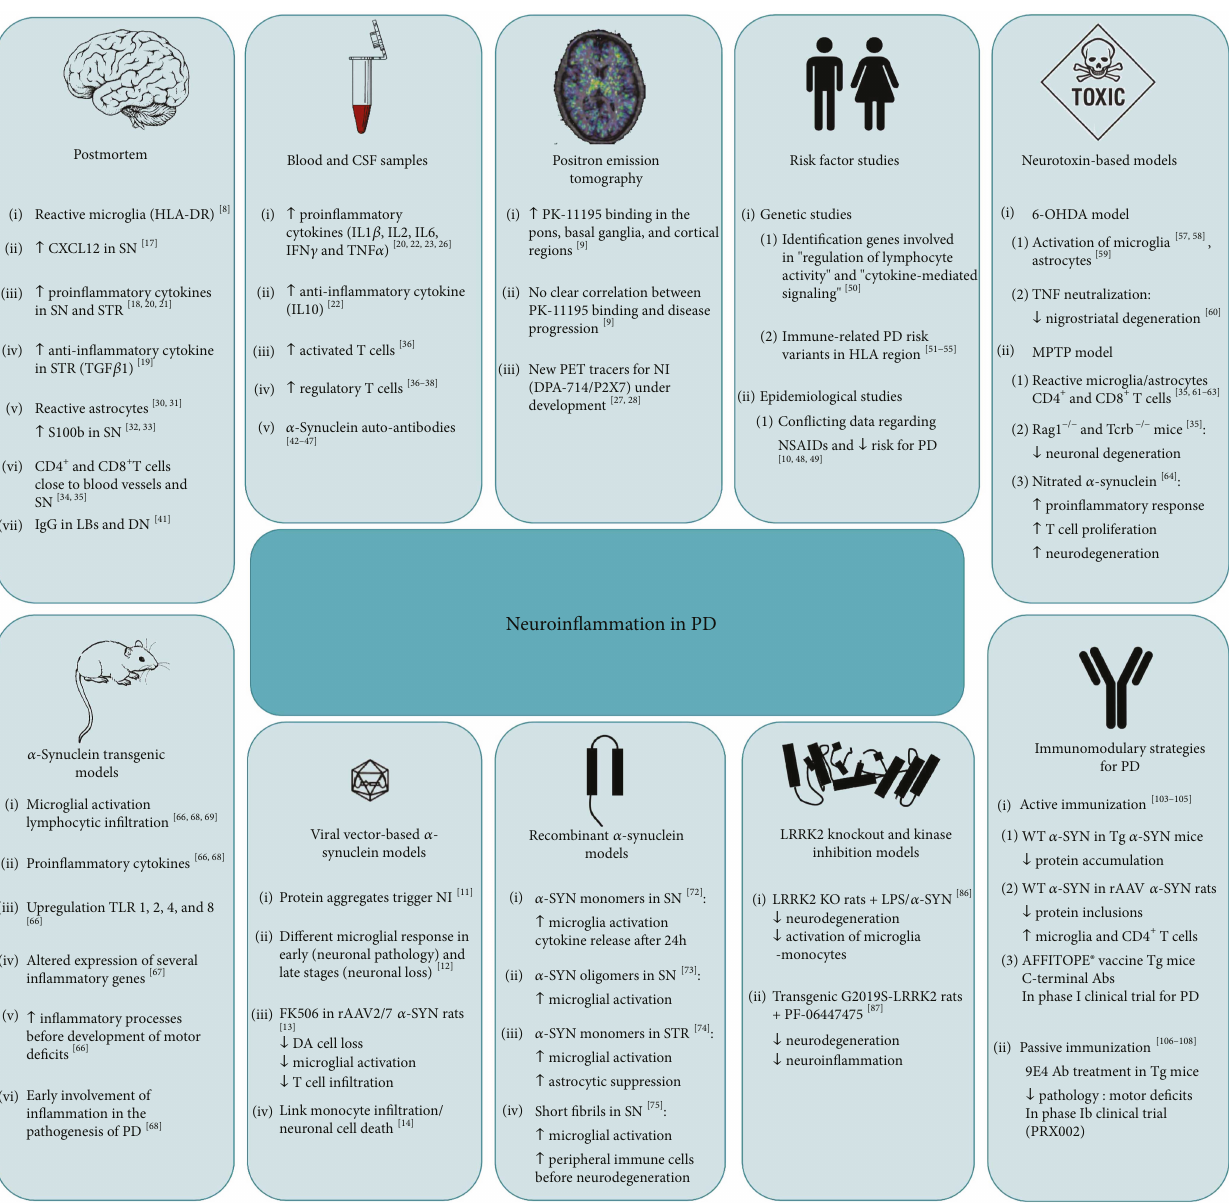
Figure 1: Overview of clinical and preclinical evidence linking neuroin fl ammation to neurodegeneration in Parkinson ’ s disease. DN: dopaminergic neurons; TLR: toll-like receptor; STR: striatum; Tg: transgenic; PD: Parkinson ’ s disease; KO: knockout; LBs: Lewy bodies; α -SYN: α -synuclein; NI: neuroin fl